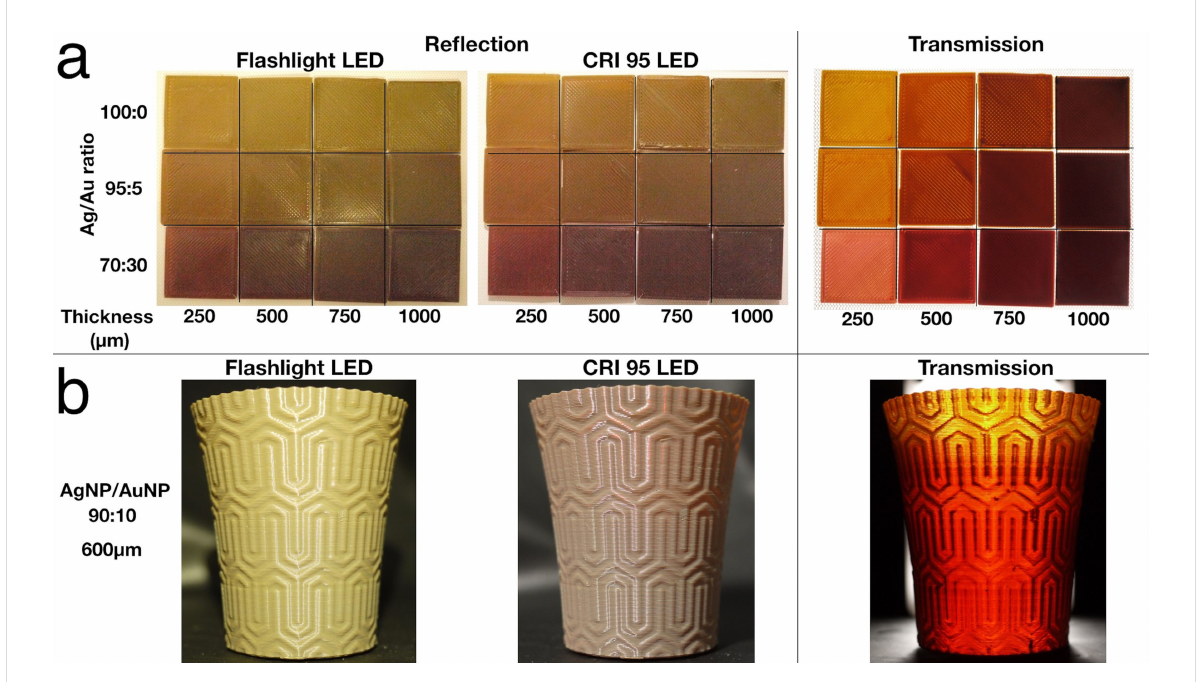
Figure 3: a) 3D printed square specimens using a different ratio of Ag/Au and various thicknesses. In reflection, the flashlight LED causes a more greenish colour reflection, while the CRI 95 LED shows a more brownish reflection. The brown reflection increases when increasing the amount of AuNP in the nanocomposite, this is due probably to the absorption of the nanoparticles. In transmission, the thicker the material, the redder the colour transmitted. b) A 3D printed cup using a ratio of Ag/Au of 90:10 and a thickness of 600 µm under different illumination systems, which shows the same dichroic effect of the Lycurgus